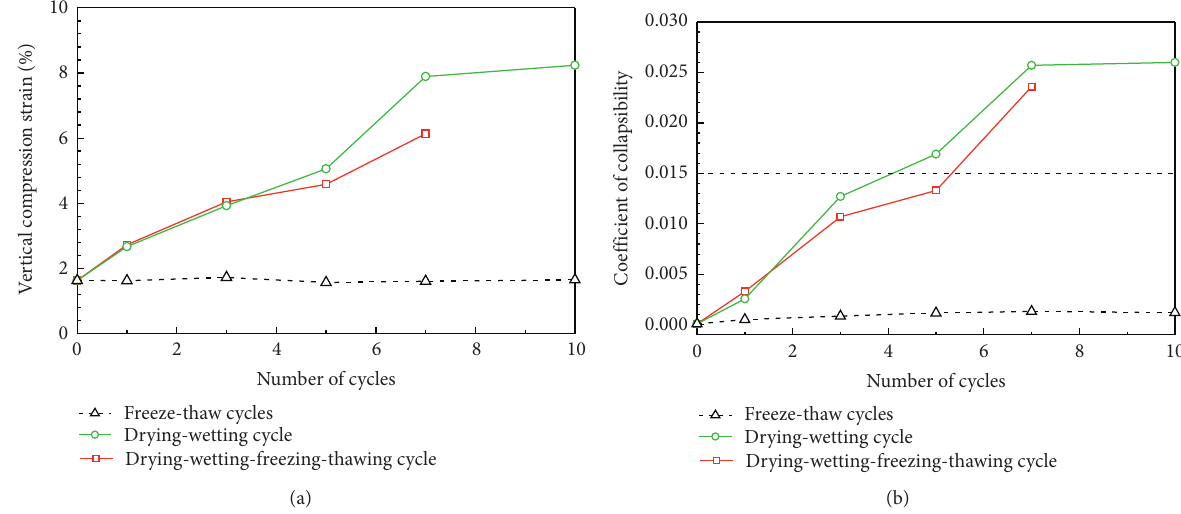
Figure 7: Variation in vertical compression strain (a) and coefficient of collapsibility (b) of compacted loess specimens at a load of 200 kPa during wetting-drying, freeze-thaw, and wetting-drying-freezing-thawing